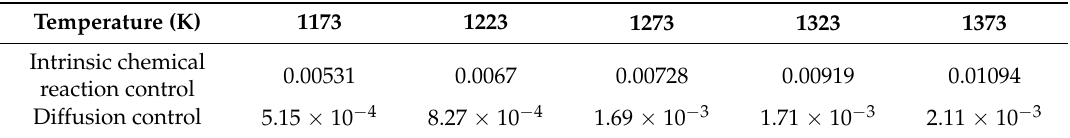
Table 3. Values of gasification rate constant at 1173–1373 K in the mixture of CO 2 , H 2 O, CO, H 2 , and N 2 atmosphere.